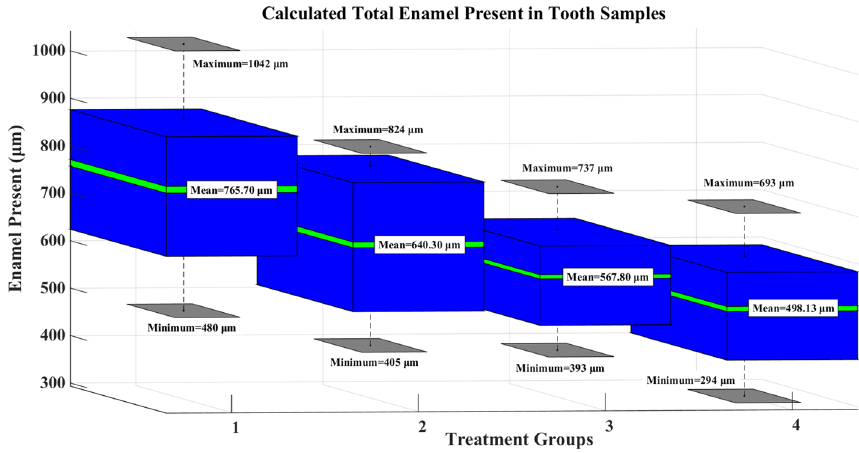
Figure 10. Total calculated enamel present in the en face OCT images of tooth samples after each treatment procedure. Treatment groups 1 to 4 represent the control group; after pumice, etch and bonding agent application group; after first debonded sample group; and after second debonding sample group. The mean, maximum, and minimum values in each group are given in the 3D box